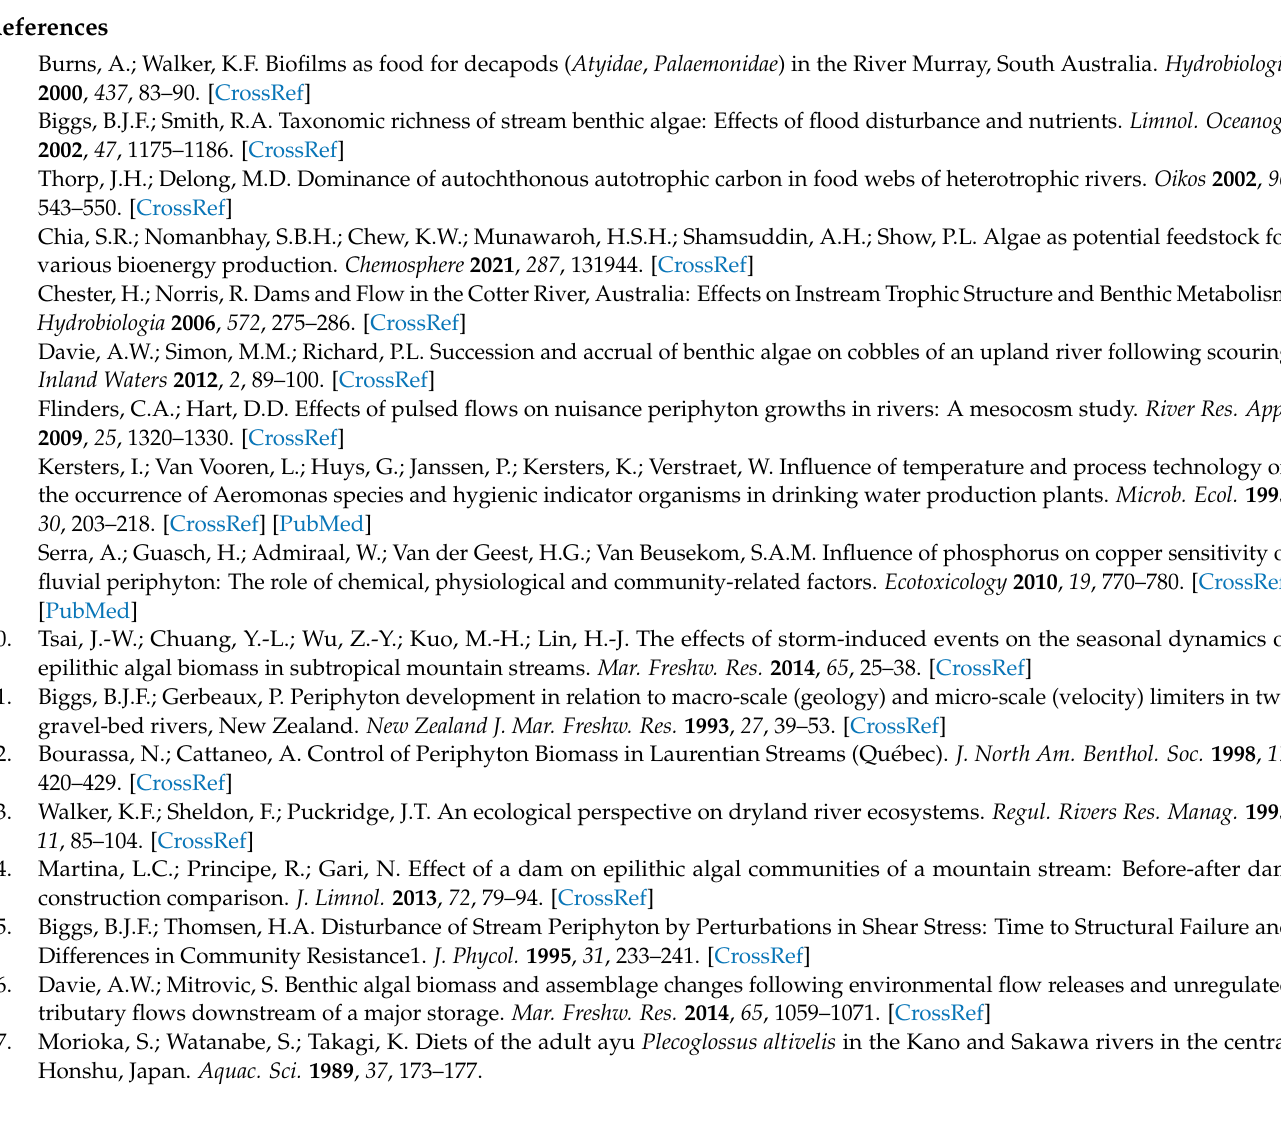
Figure A1. Relationship between the flow velocity and motor speed.